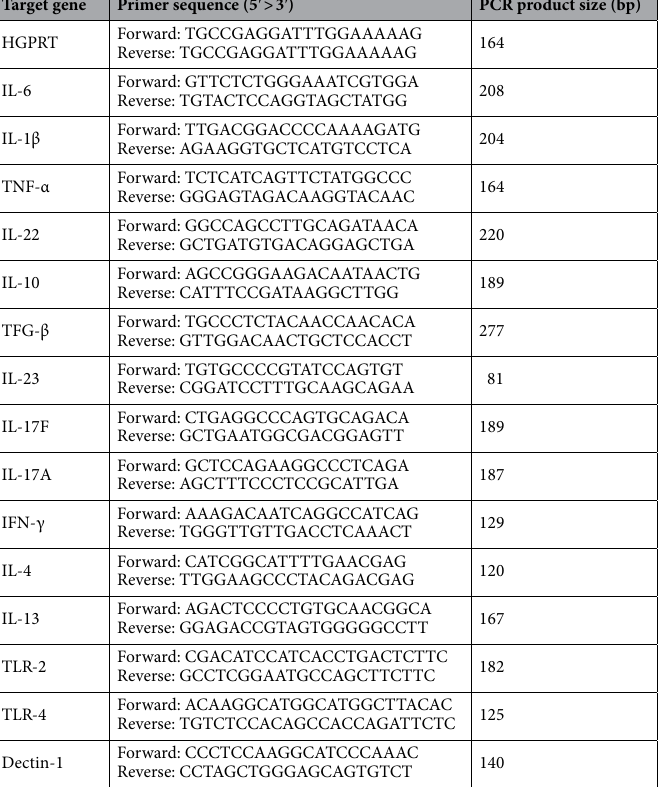
Table 2. Sequences of oligonucleotide primers used for quantitative RT-PCR analysis.